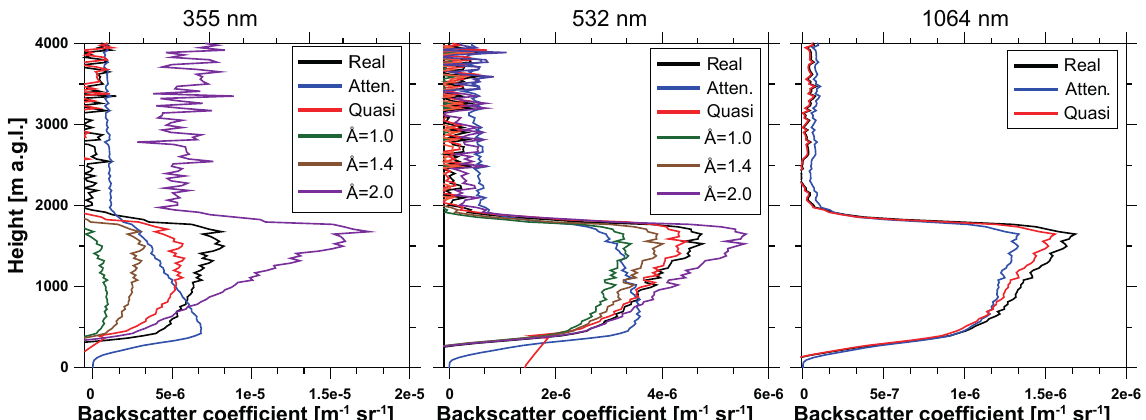
Figure 5. Comparison of the particle backscatter coefficient determined with the Klett method, the attenuated backscatter coefficient, and quasi-particle-backscatter coefficient for the three laser emission wavelengths on 22 April 2013, 14:20–14:50UTC. Additionally, the quasi- particle-backscatter coefficient with a different approach for attenuation correction (extinction coefficient derived from the 1064nm extinction coefficient with the Ångström relation) is plotted for Ångström exponents of Å = 1 . 0, 1.4, and 2.0